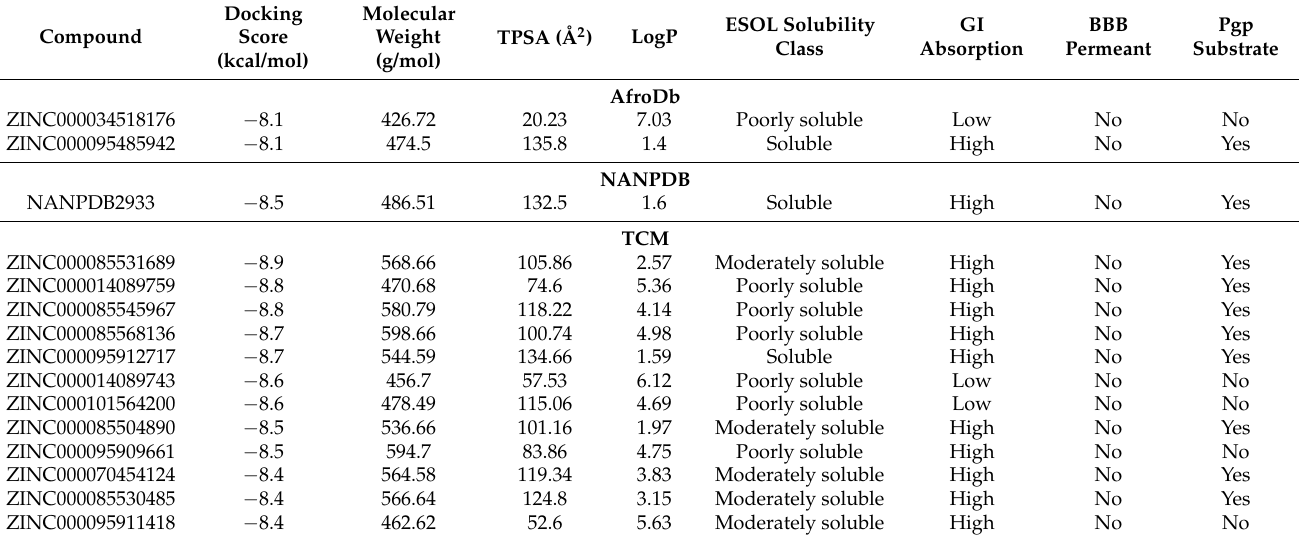
Table 2. Physicochemical and biological properties of some of the shortlisted compounds predicted using